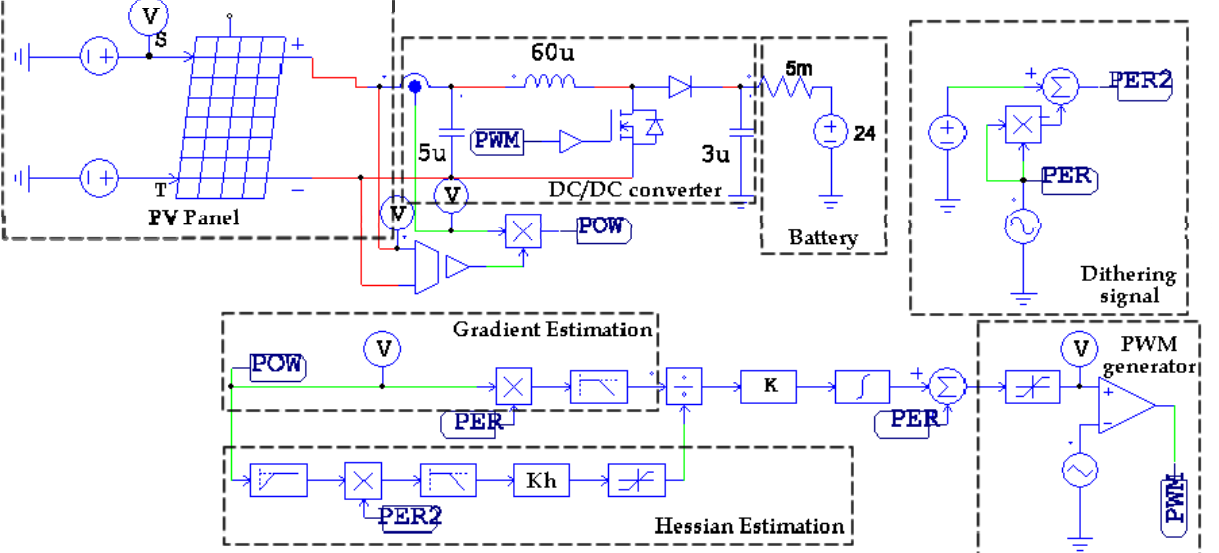
Figure 7. PSIM schematic of the solar system in NL-ESC